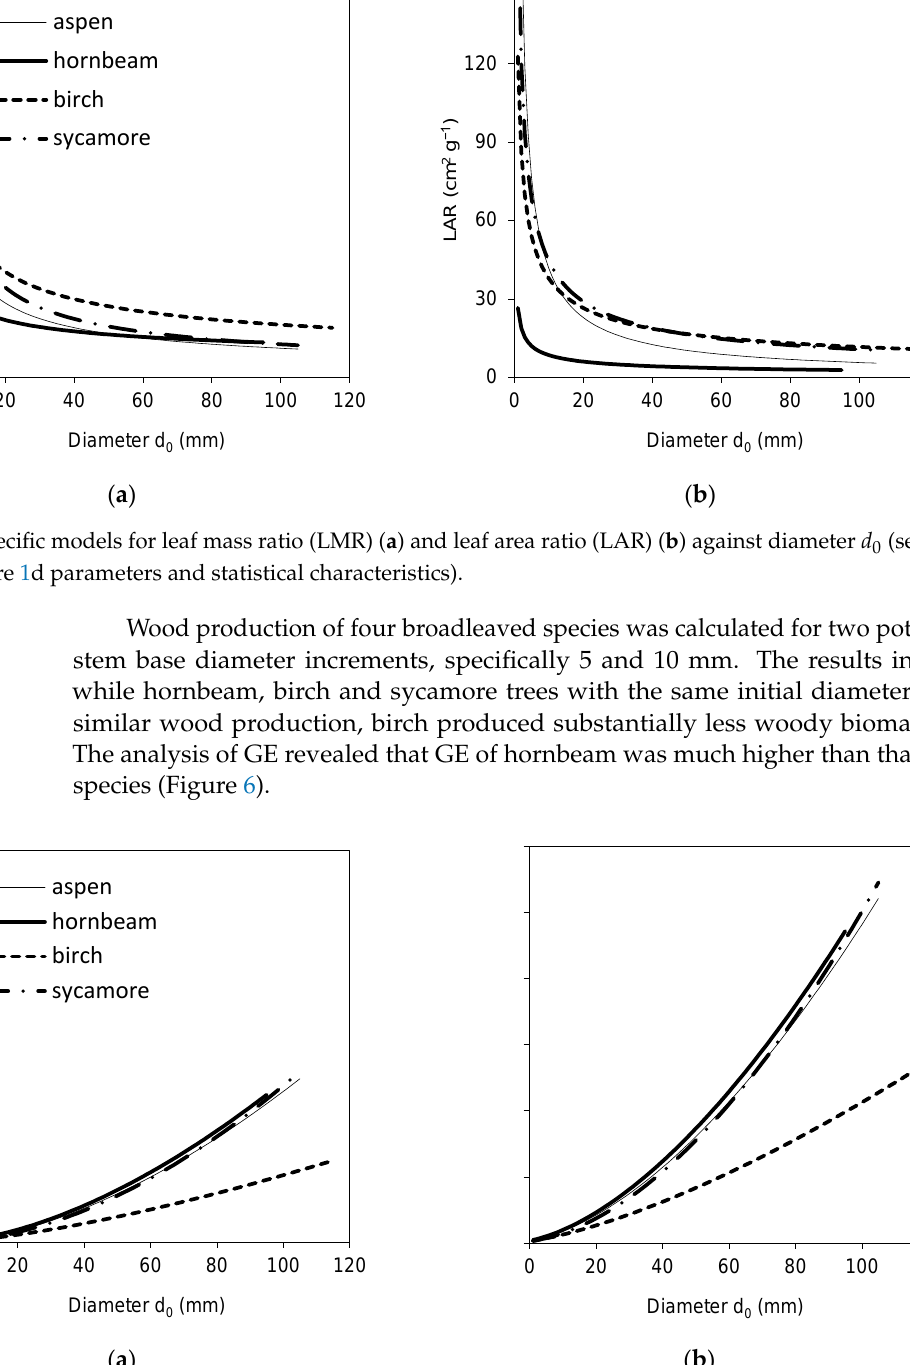
Figure 5. Species-specific models for the annual production of woody parts biomass, i.e., branches, stem and roots together, against the initial diameter d 0 considering annual diameter increment of 5 mm ( a ) and 10 mm ( b ). Algorithms for calculation of the points on the curves are given in the Materials and Methods section (Equation (10)).